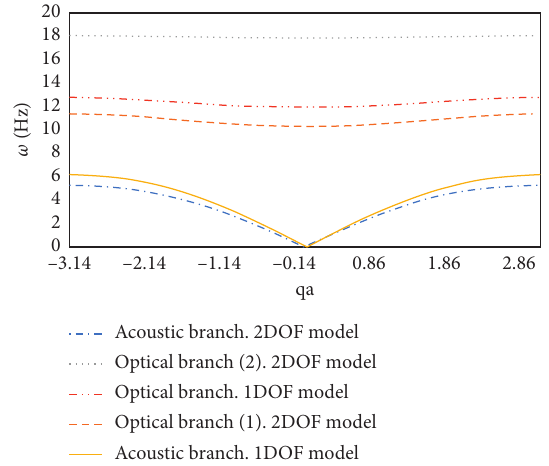
Figure 15: Comparison of dispersion curves in two